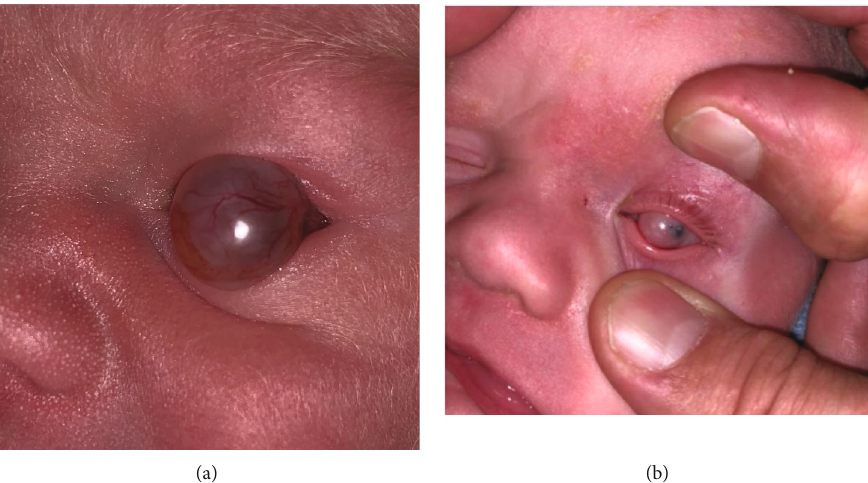
Figure 1: (a) External photograph taken on the day of birth showing the cystic lesion protruding from the ocular surface. (b) External photograph taken at 2 months. Mild regression of protrusion with persistent corneal coverage.